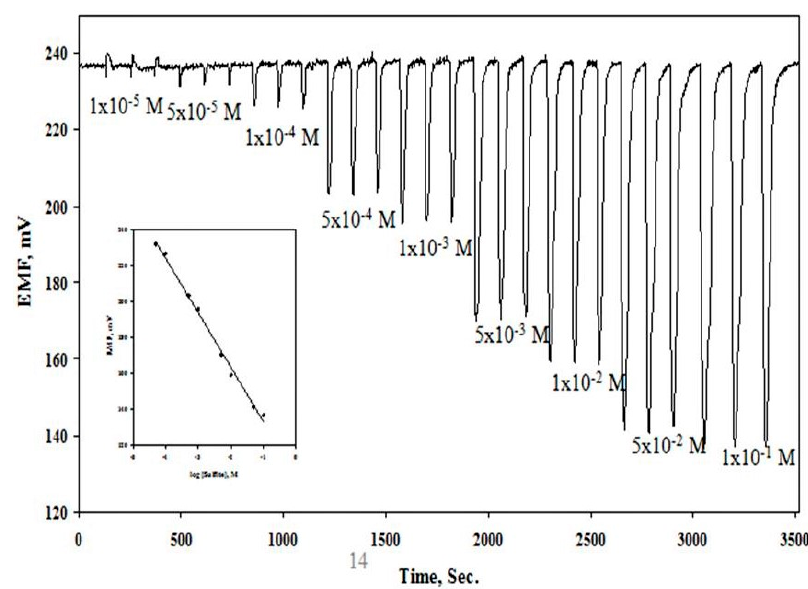
Figure 5. Potentiometric FIA chart for sulfite calibrants using [CoPC/TDMA + / o -NPOE] PVC membrane.